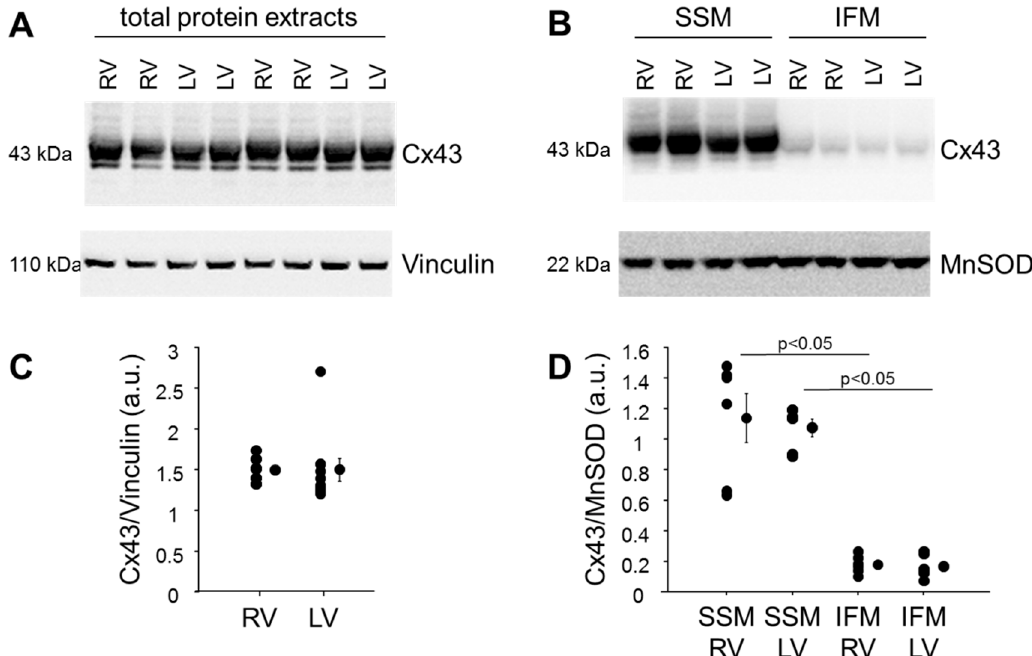
Figure 1. Amount of Cx43 in left and right ventricular total and mitochondrial protein extracts. Western blot analysis was performed for Cx43, Vinculin (housekeeping protein used for total protein extracts) and MnSOD (manganese superoxide dismutase—housekeeping protein used for mitochondrial protein extracts) on proteins isolated from right and left mouse (C57Bl6/J) ventricular tissue ( A ) or on subsarcolemmal (SSM) and interfibrillar (IFM) mitochondrial proteins, isolated from mouse right (RV) and left (LV) ventricular tissue ( B ). A and B demonstrate uncut, representative parts of the Western Blot analysis. The amounts of Cx43 were normalized to Vinculin ( C , n = 10) or MnSOD ( D , n = 6). The purity of the mitochondrial preparations was demonstrated by the absence of marker proteins for other cellular compartments (plasma membrane, cytosol and nucleus, Supplementary Materials Figure S1). Data were compared by unpaired Student’s t-test (total proteins) or by two-way ANOVA (mitochondrial proteins). The study was approved by the animal welfare office of the Justus-Liebig University, Giessen, Germany (522_M, approved 29 November 2019).